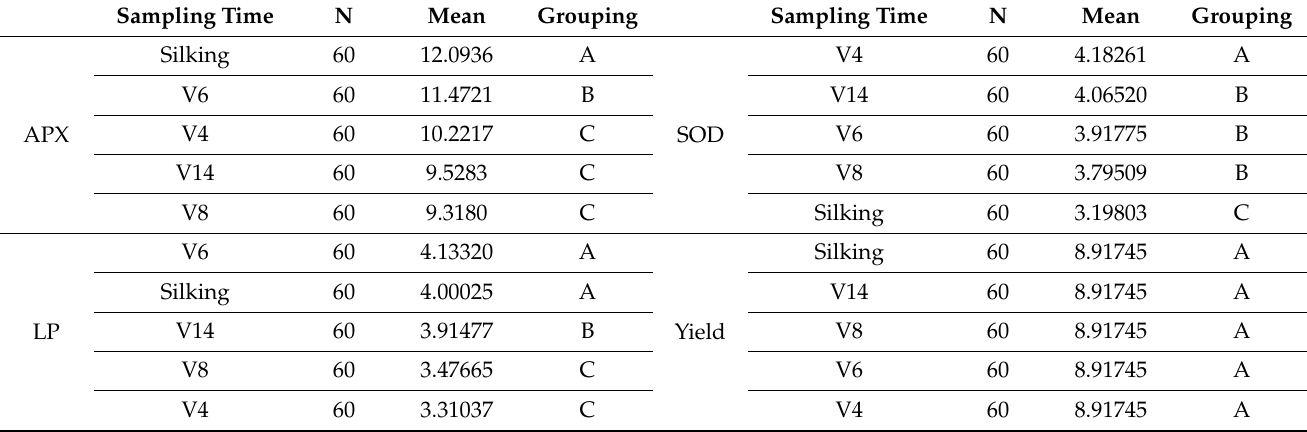
Table 7. Tukey grouping based on the NPK